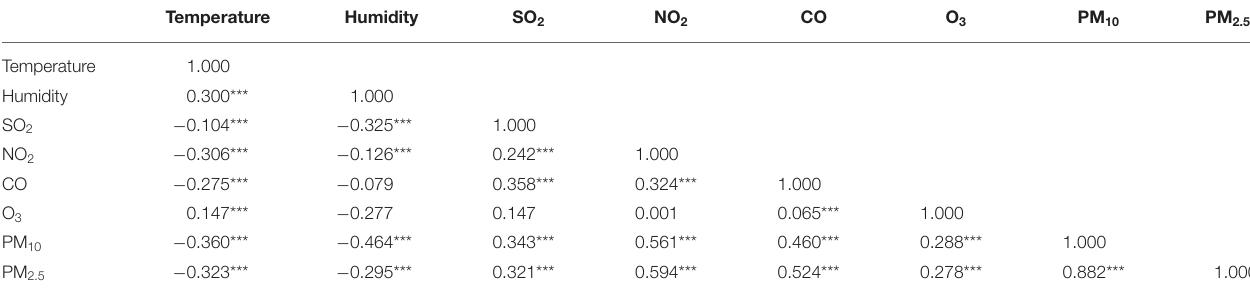
TABLE 2 | The Spearman’s rank correlation coefficient between the daily ambient air pollutant and meteorological parameters. Temperature